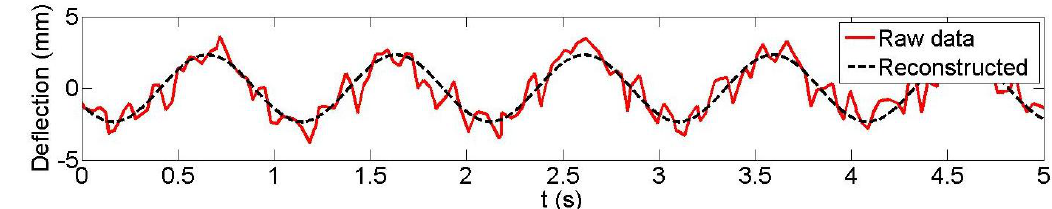
Figure 8. Kinect observed and reconstructed vertical displacements ( = 1 Hz), dataset 5 witness plate 7.